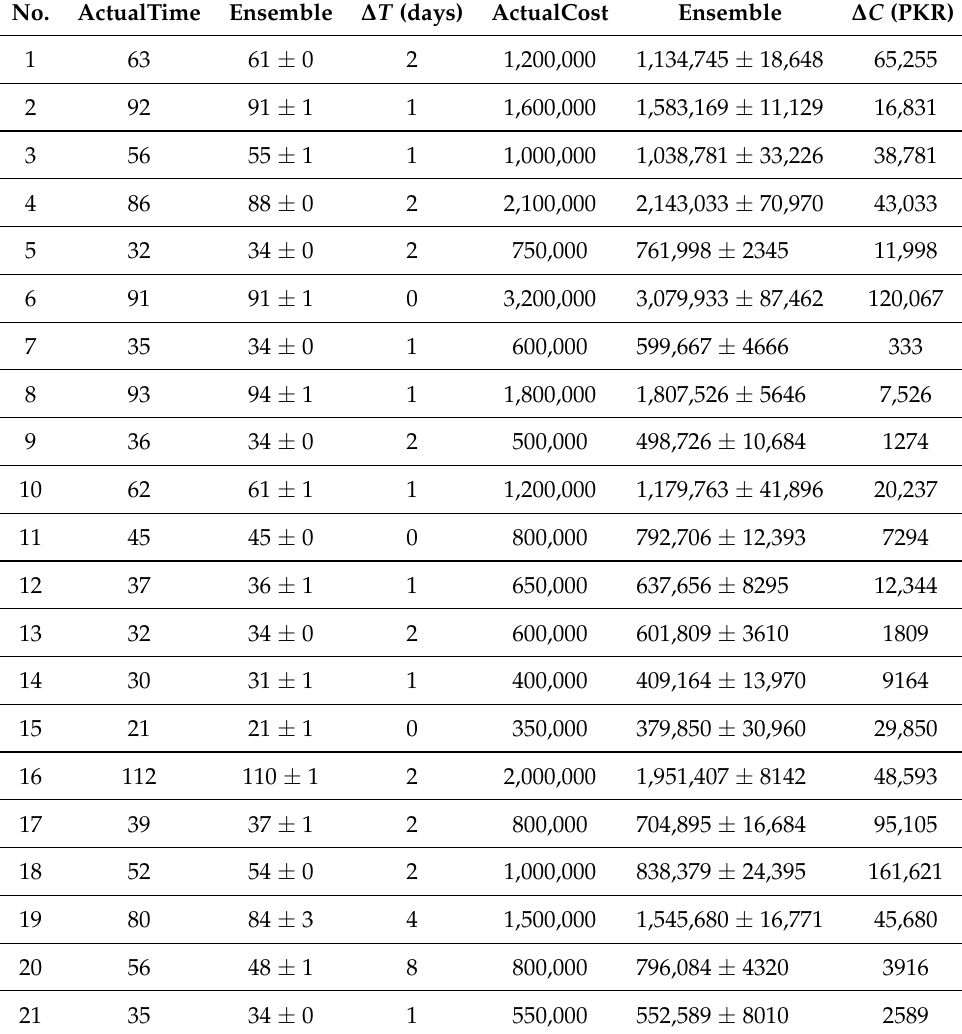
Table 17. Bagging ensemble results for completion time and total cost of the 21